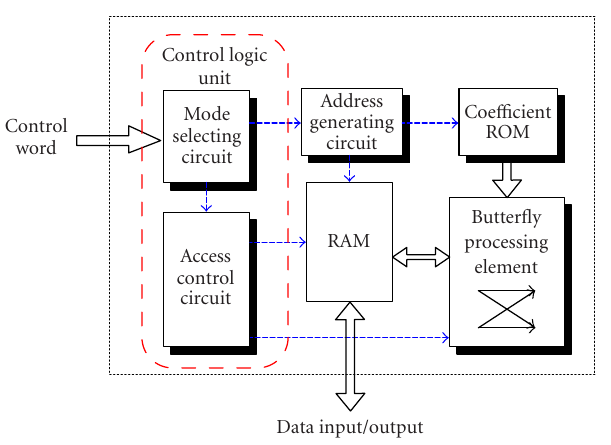
Figure 4: The proposed variable-length FFT/IFFT processor archi-